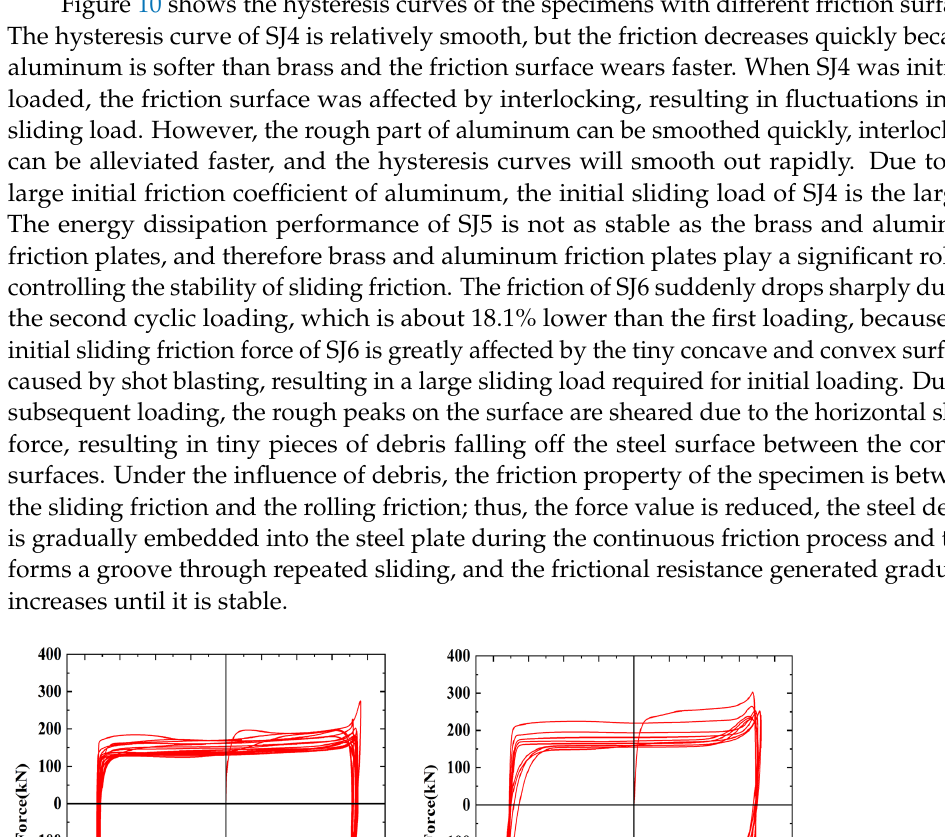
Figure 9. The energy dissipation analysis of SJ1, SJ2, and SJ3: ( a ) Energy dissipation; ( b ) Cumulative energy dissipation.